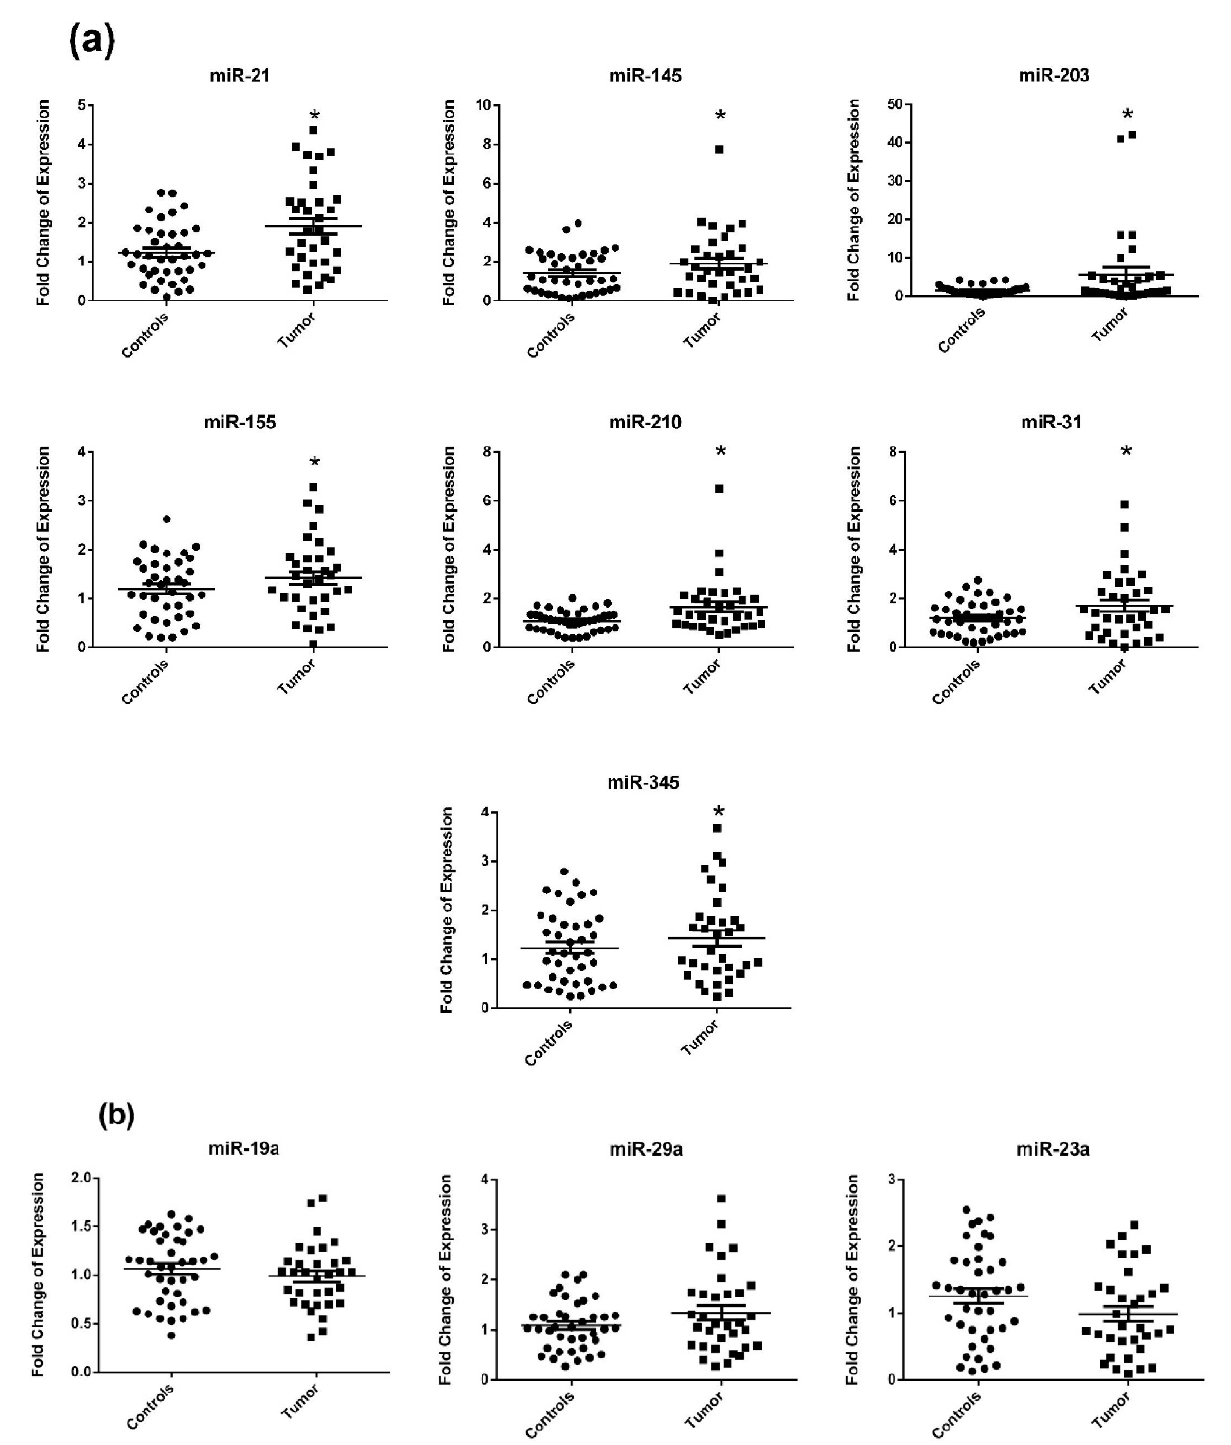
Figure 1. miRNA expression in plasma of newly diagnosed surgery naïve Stage IV colorectal cancer (CRC) patients compared to healthy subjects. ( a ) Significantly dysregulated miRNA ( b ) Non-significantly dysregulated miRNA. The dotplots represent the mean (middle line) and the standard error of mean (error bars). miR-16 was used as an endogenous control. * denotes p -value < 0.05 according to Wilcoxon’s signed-rank test.